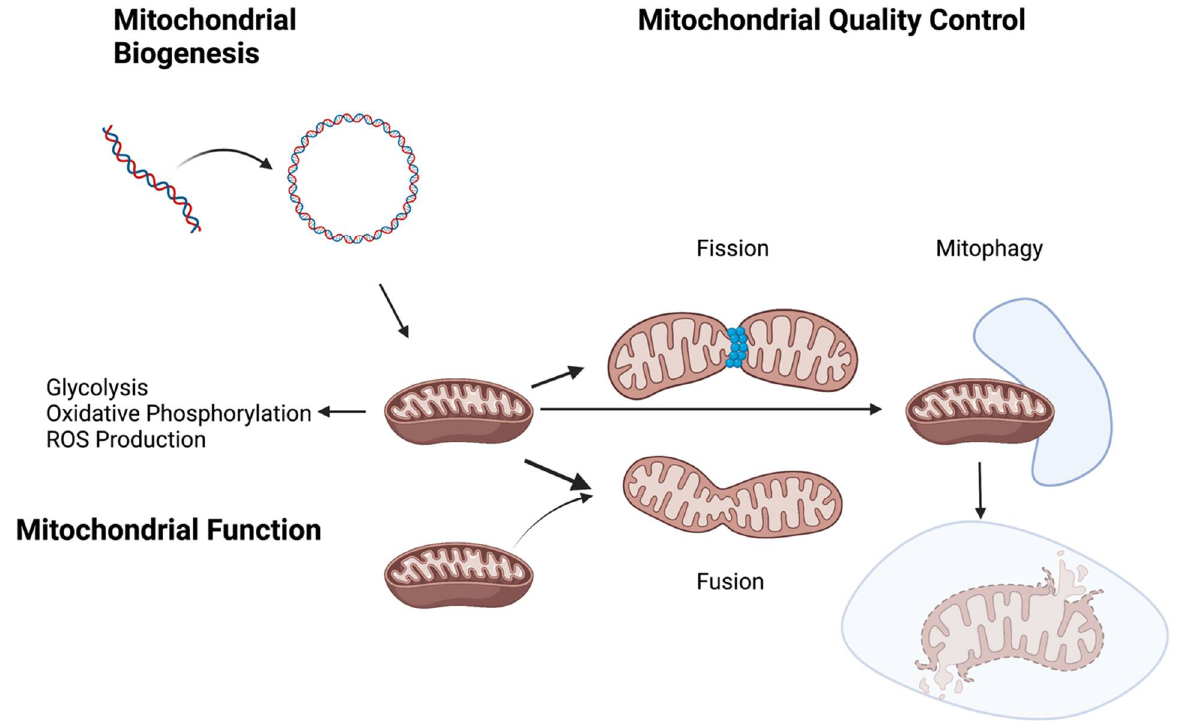
Figure 1. The disruption to several metabolic and/or mitochondrial processes, such as the glycolytic switch and oxidative phosphorylation, as well as changes in mitochondrial biogenesis and quality control, have been associated with the development of pulmonary hypertension. Created with Bio- Render.com.